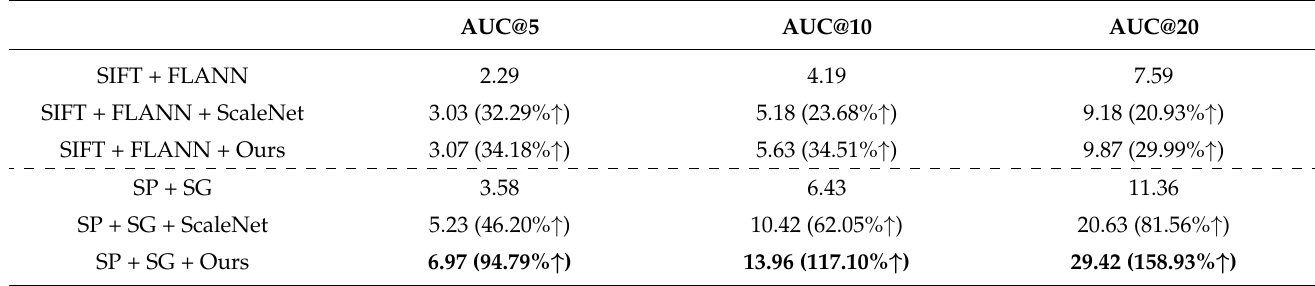
Table 6. Pose estimation in the VariableLight